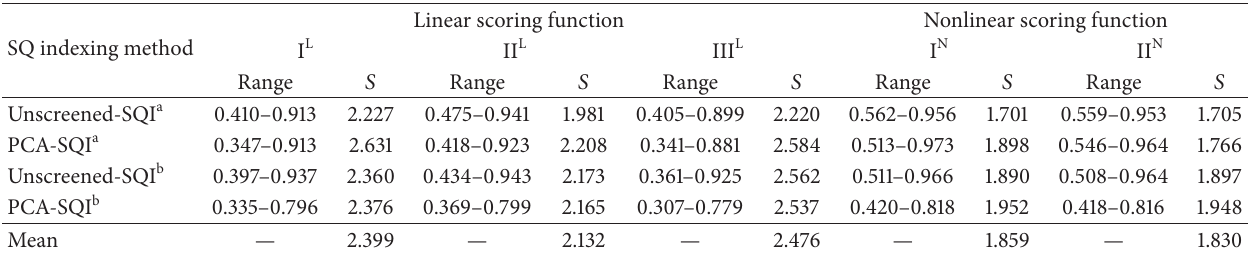
Table 7: Dataset selection, scoring function, and indexing method comparisons for eight LUSMS in the Mai-Negus catchment of northern